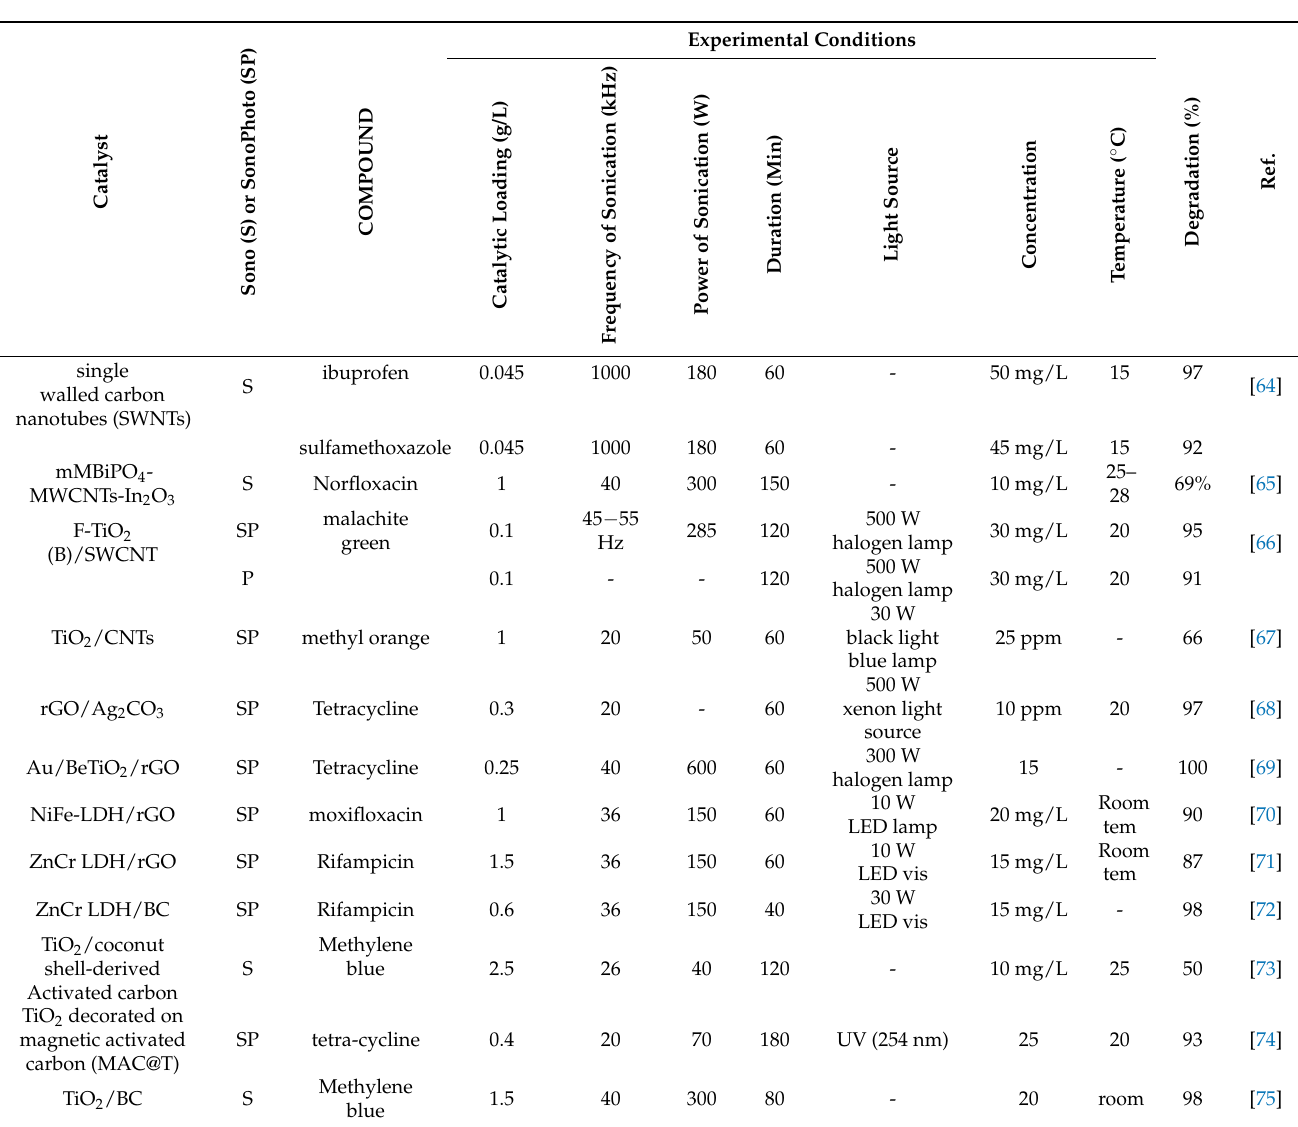
Table 1. Sonocatalytic and sonophotocatalytic degradation of organic pollutants using characteris- tic